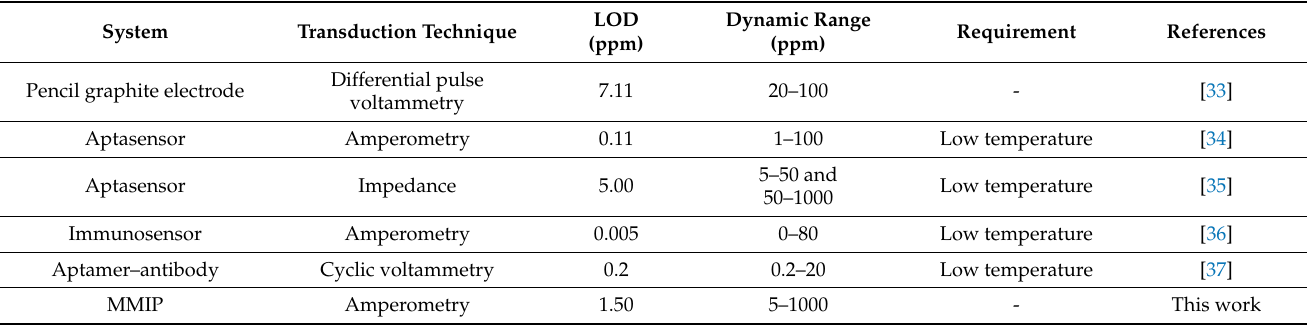
Figure 5. Amperometry responses of the MMIP-modified electrode in the detection of different gluten concentrations ( a ). The calibration curves of gluten, as detected by the MMIP-modified electrode ( b ). Table 1. Comparison of the analytical performance of electrochemical assays for gluten